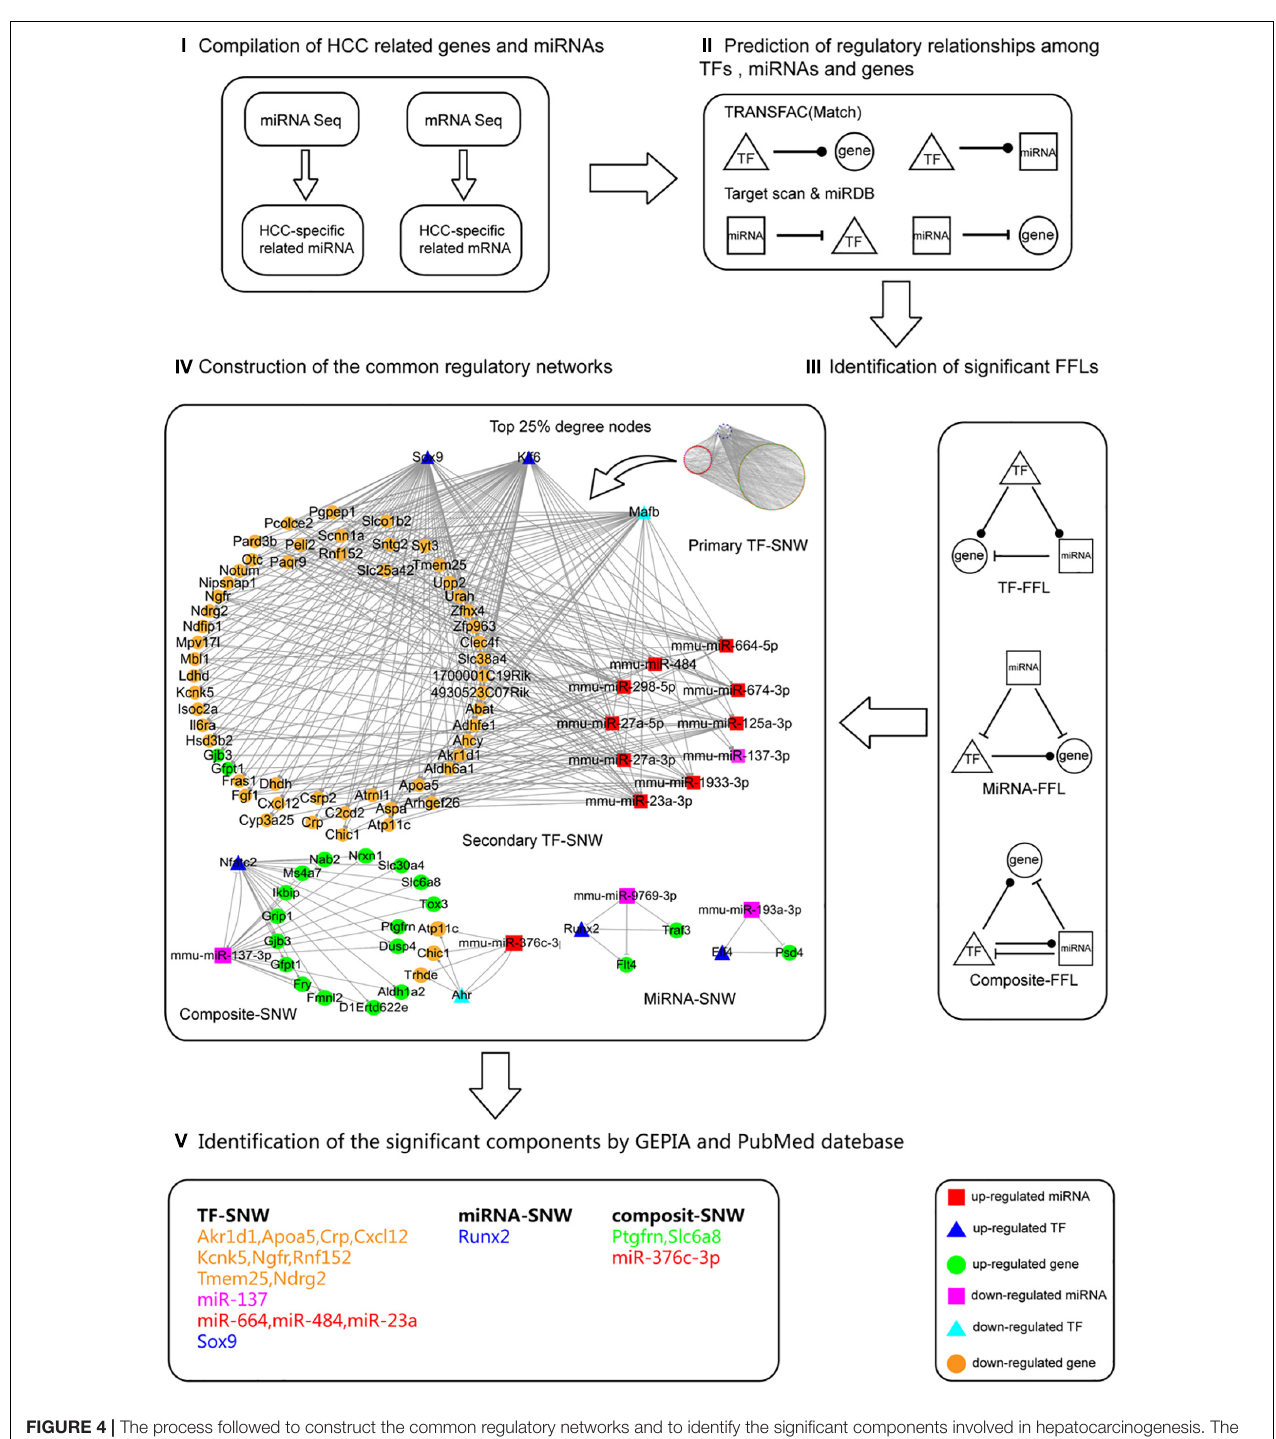
FIGURE 4 | The process followed to construct the common regulatory networks and to identify the significant components involved in hepatocarcinogenesis. The process followed contained five steps. (I) Data compilation. The HCC commonly related miRNAs [38 up-regulated (T > P = W); 5 down-regulated (T < P = W)] and mRNAs [646 up-regulated (T > P = W); 323 down-regulated (T < P = W)] in both males and females were selected for further analysis. (II) Prediction of the regulatory relationships between TFs, miRNAs, and genes. The four regulatory relationships include TF-gene, TF-miRNA, miRNA-gene, miRNA-TF. (III) Identification of significant FFLs. Based on the above regulatory relationships, the significant 3-node FFLs were identified. (IV) Construction of the shared regulatory networks. These FFLs were categorized into TF, miRNA, and composite sub-networks (SNWs). Among these three SNWs, TF-SNW is the most redundant. By using the hub definition method, we determined the top 25% degree nodes of genes, miRNAs, and TFs as the member of secondary TF-SNW to focus on the most significant components. (V) Identification of the significant components using GEPIA and PubMed database. All nodes in the three SNWs (secondary TF-SNW, miRNA-SNW, composite-SNW) were filtered based on the GEPIA and PubMed